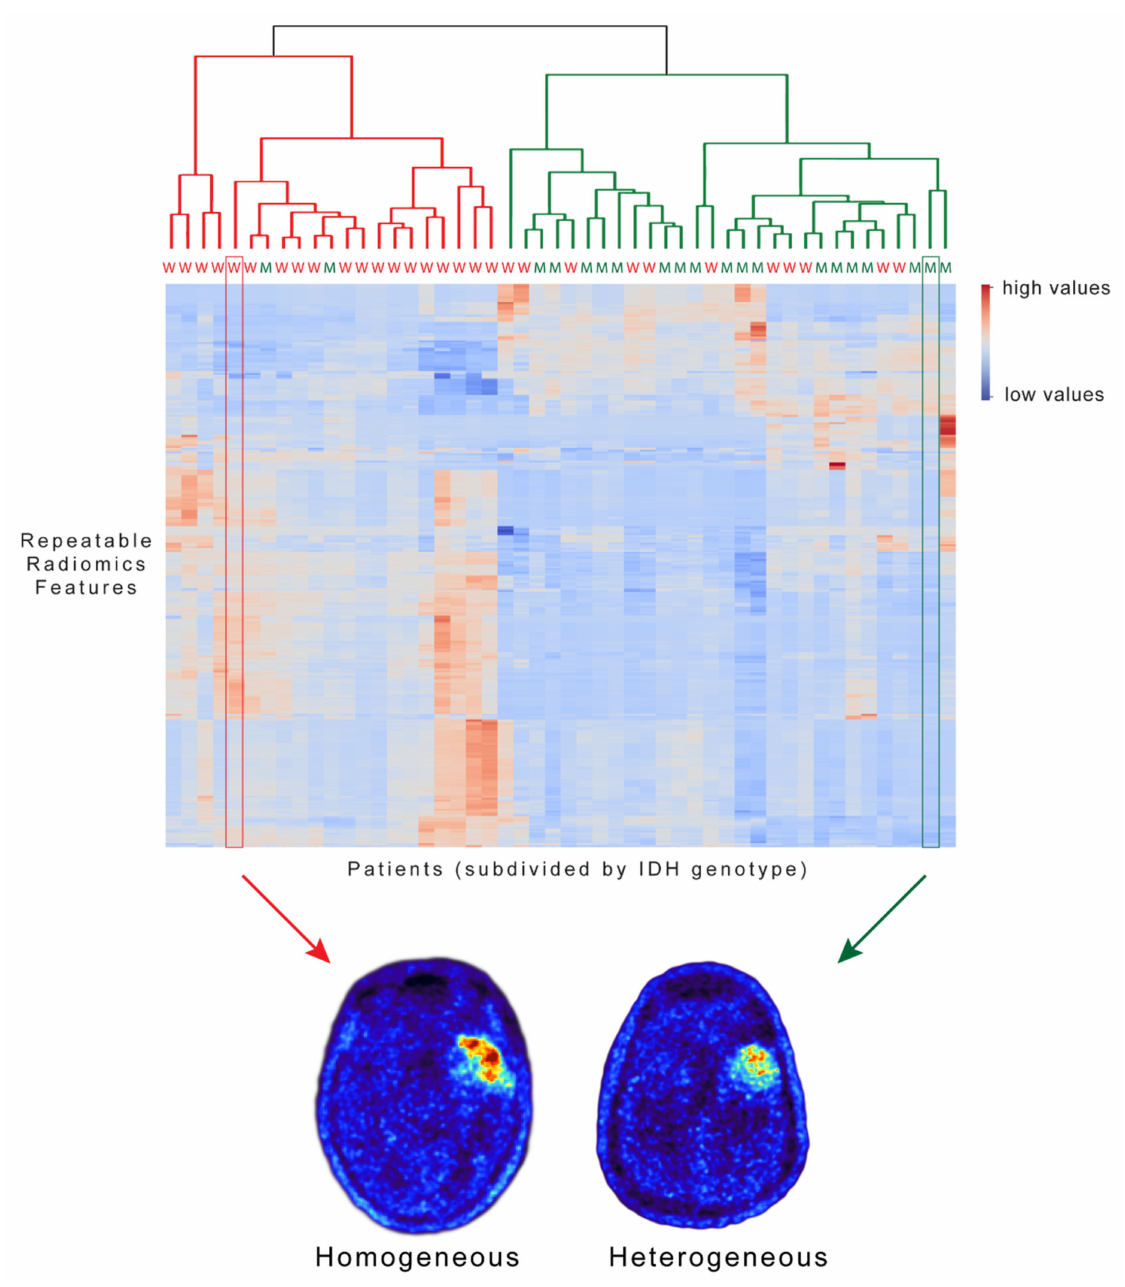
Figure 8. Hierarchical cluster analysis using repeatable FET PET radiomics features. Heatmap represents the absolute radiomics feature values, with higher feature values shown in red and lower values in blue. Each row represents a single feature (n = 297). Each column represents a single patient (n = 50) with a known IDH genotype (W = IDH-wildtype (red); M = IDH-mutant (green)). Features were calculated for the tumor regions. The dendrogram represents the cluster distance indicating the order in which clusters were